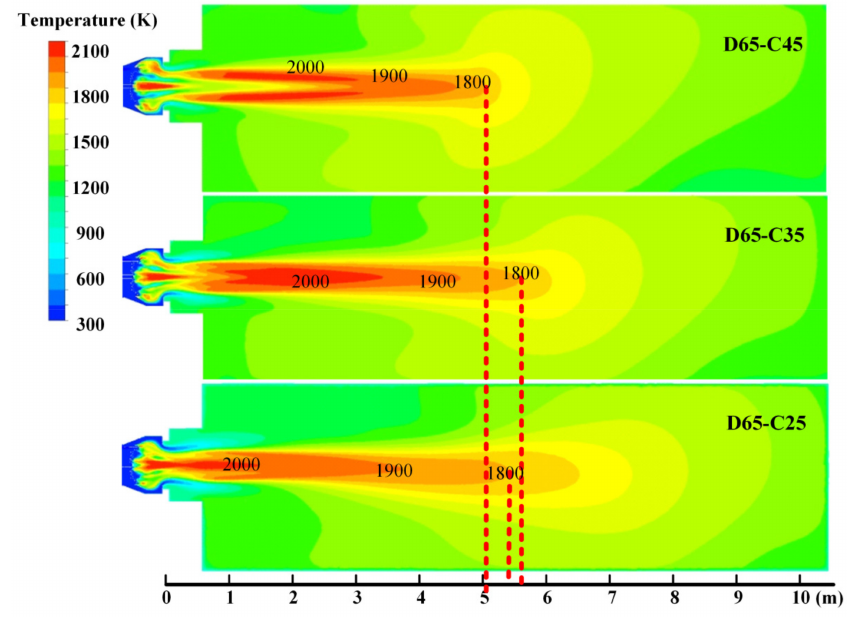
Figure 20. Temperature distribution of D65-C45, D65-C35, and D65-C25 in the center section.